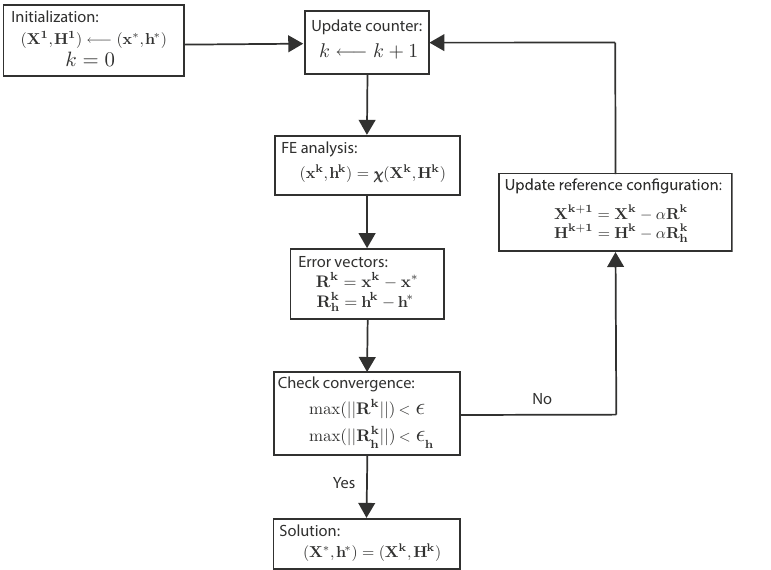
Figure 3. Algorithm for the prestress methodology to identify an appropriate traction-free reference configuration given available (in vivo) geometries from medical